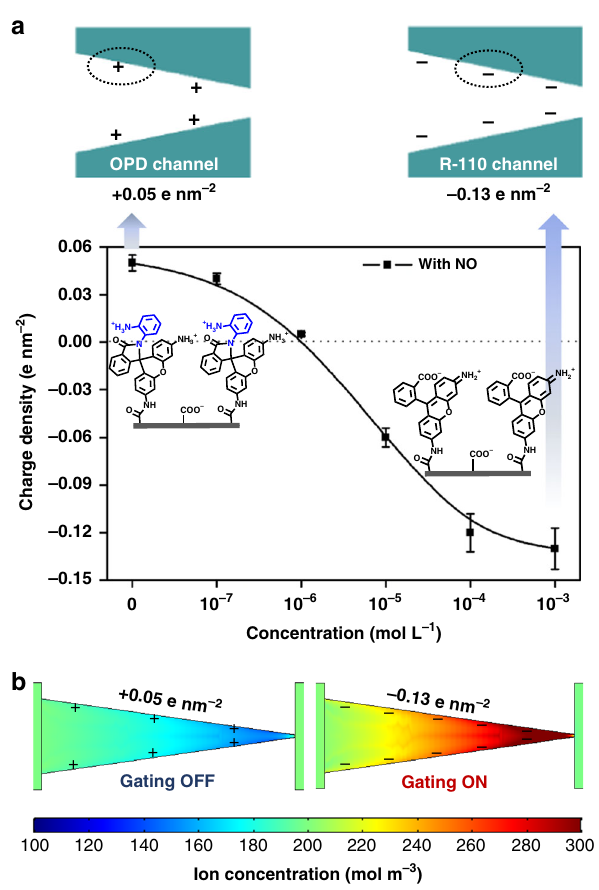
Fig. 5 Discussion of the mechanism. a The surface charge density of the OPD channel and the R-110 channel, and the dynamic changes of surface charge density from the OPD channel to the R-110 channel (±10% was used for describing the error bars). b The numerical simulation of ion concentration (total of K + and Cl − ) distribution in the channel (at − 2 V, with 0.1 M KCl). OPD o